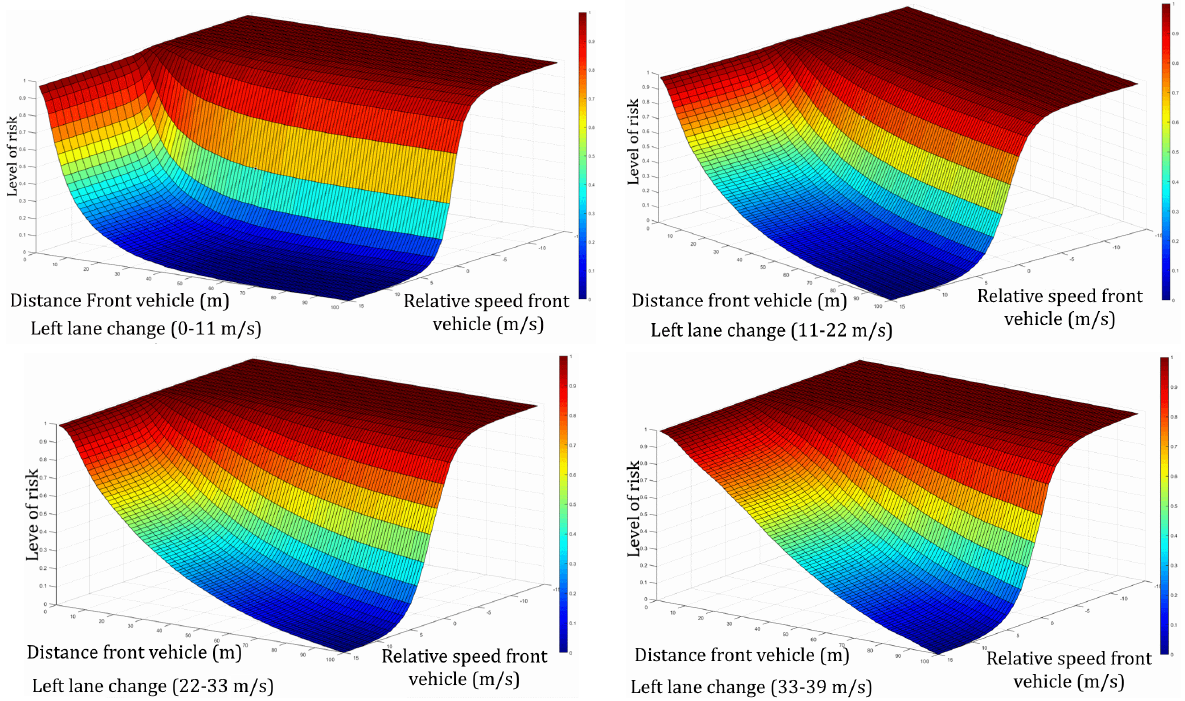
Figure 3. Standardized bi-variant cumulative histogram divided in 4 speed intervals for the front